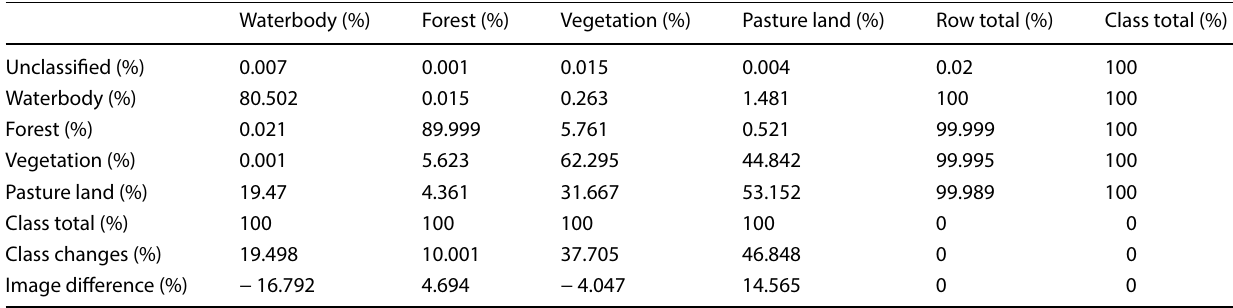
Table 7 Change detection statistics